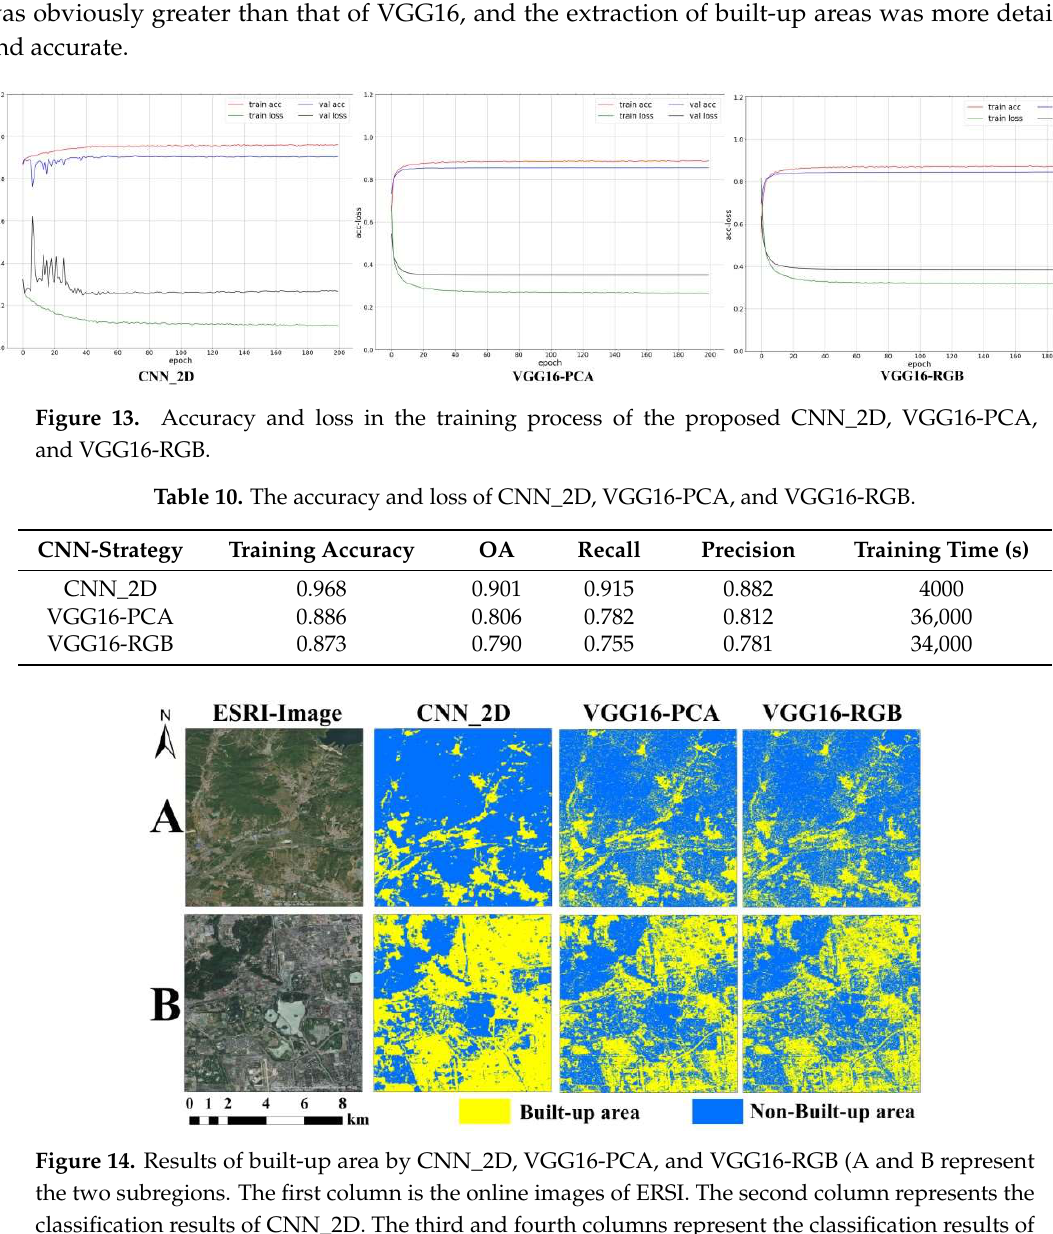
Figure 14. Results of built-up area by CNN_2D, VGG16-PCA, and VGG16-RGB.( A and B represent the two subregions. The first column is the online images of ERSI. The second column represents the classification results of CNN_2D. The third and fourth columns represent the classification results of VGG16-PCA and VGG16-RGB, respectively.)